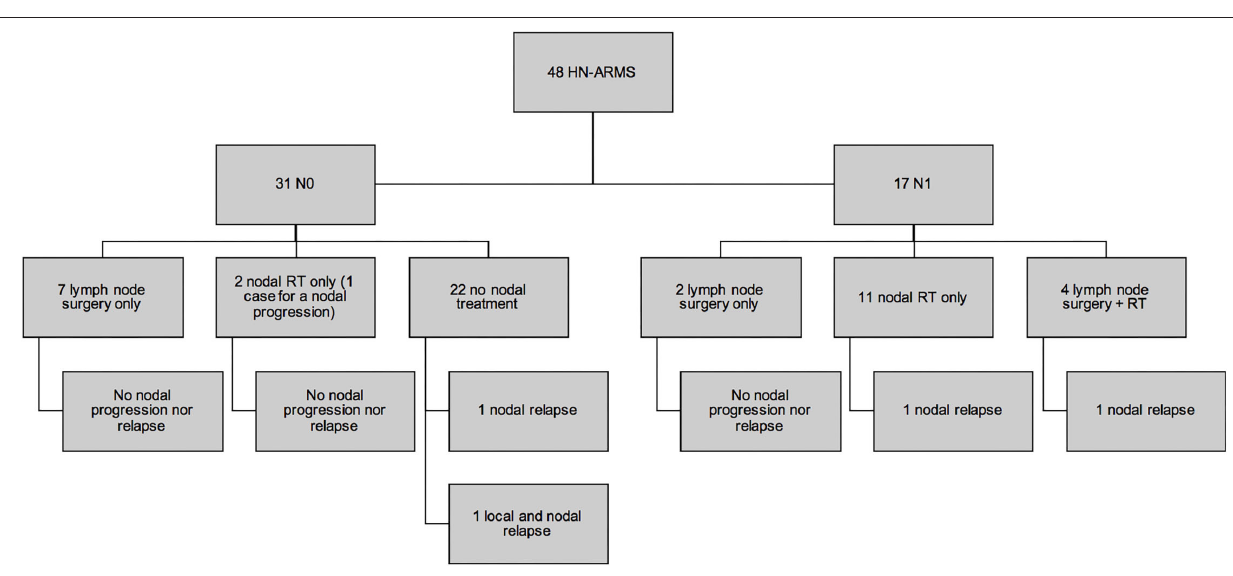
FIGURE 5 | Nodal control according to the lymph node chain treatments (surgery and radiation